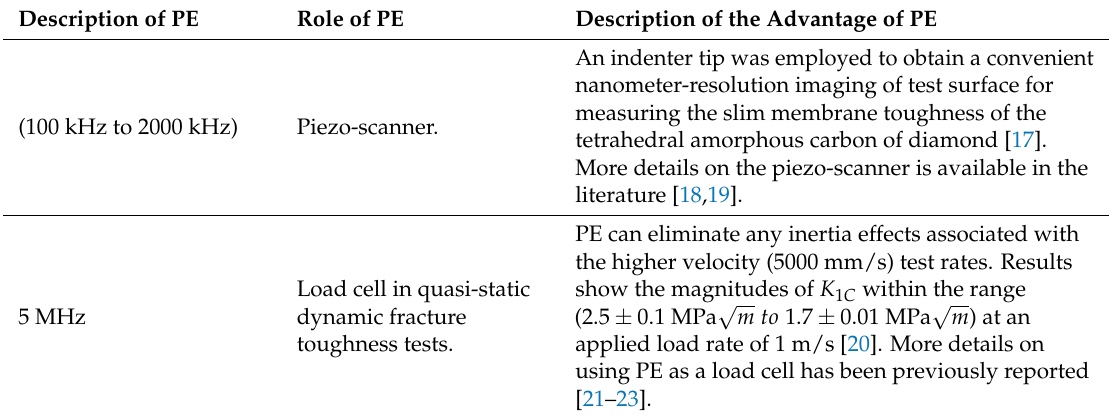
Table 1. Several piezoelectric element (PE) applications for measuring the fracture of toughness of